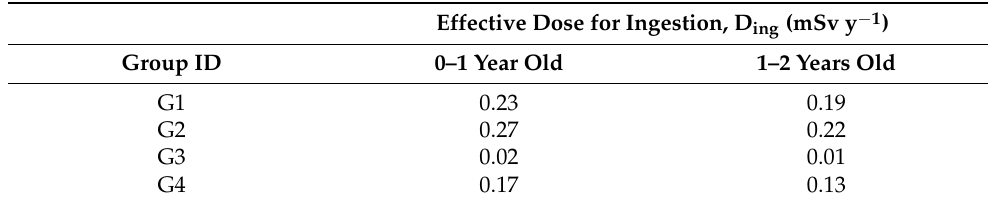
Table 3. The annual effective dose for early childhood food